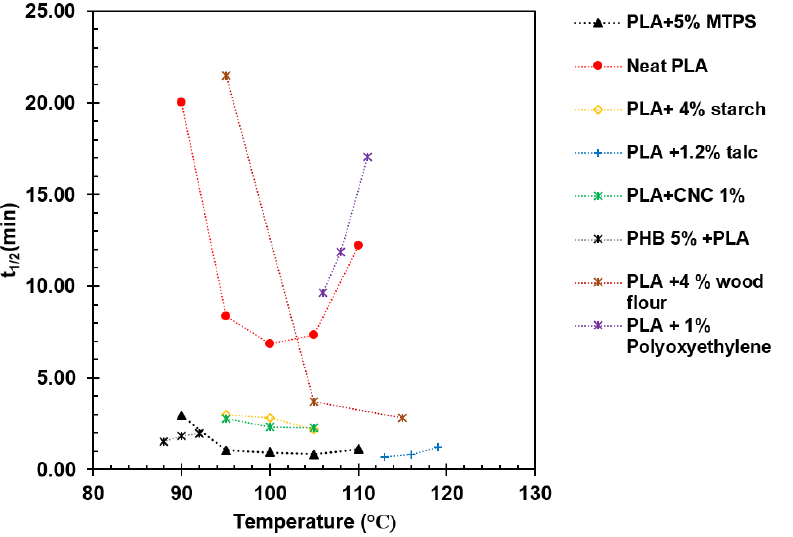
Figure 14. Comparing the t 1/2 values of PLA/MTPS blends with other nucleating agents.